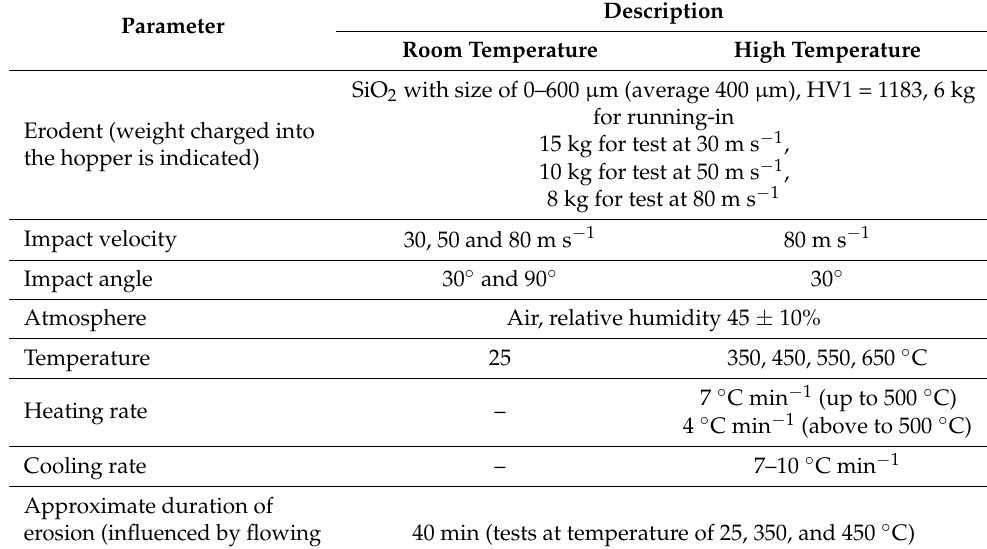
Table 3. Erosive wear test conditions (high-stress conditions due to impact).